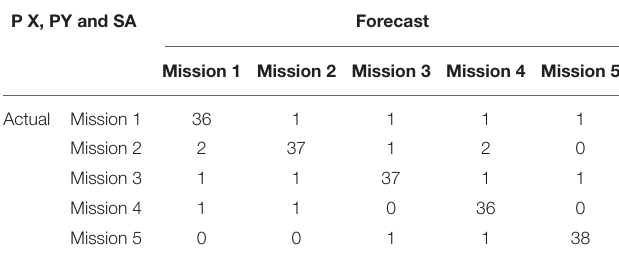
TABLE 6 | Results of the differential analysis of eye movement